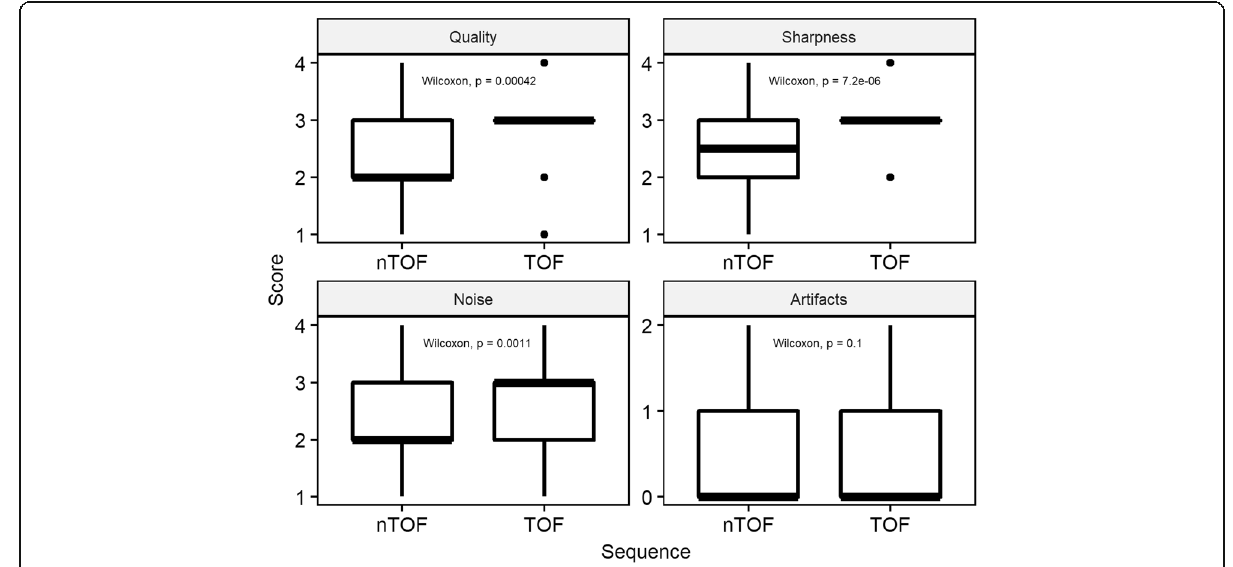
Fig. 5 Image quality rating of TOF and non-TOF